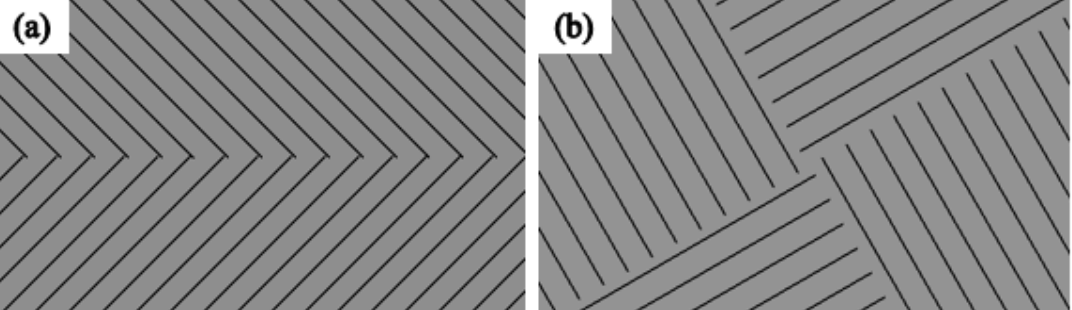
Figure 9. Mechanism of track overlap: ( a ) Overlap between two groups of scanning lines; ( b ) overlap between a single scanning line and one group of scanning